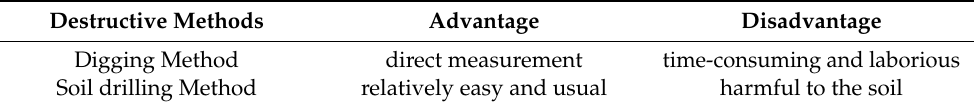
Table 1. Comparisons of Destructive methods.